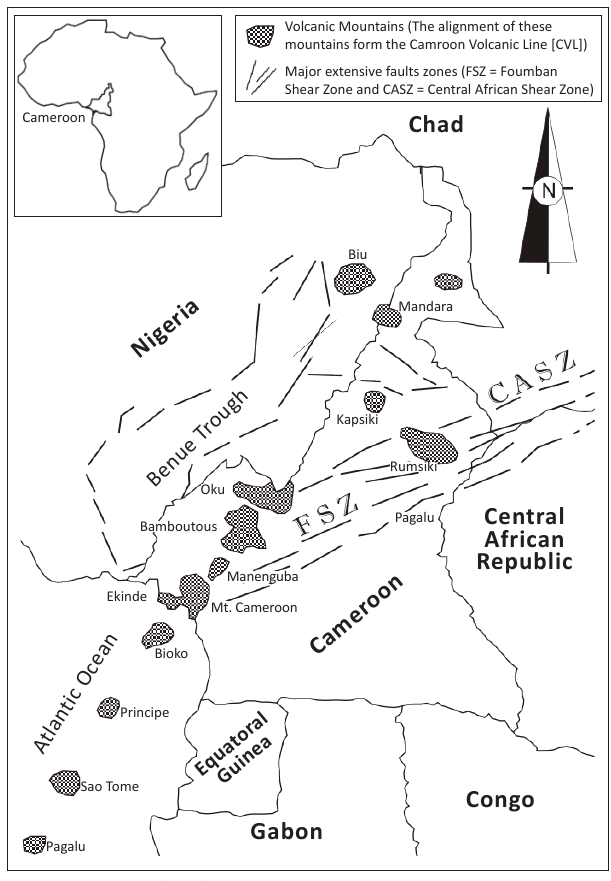
FIGURE 1: The Cameroon Volcanic Line and fault zones that are associated with natural hazards in